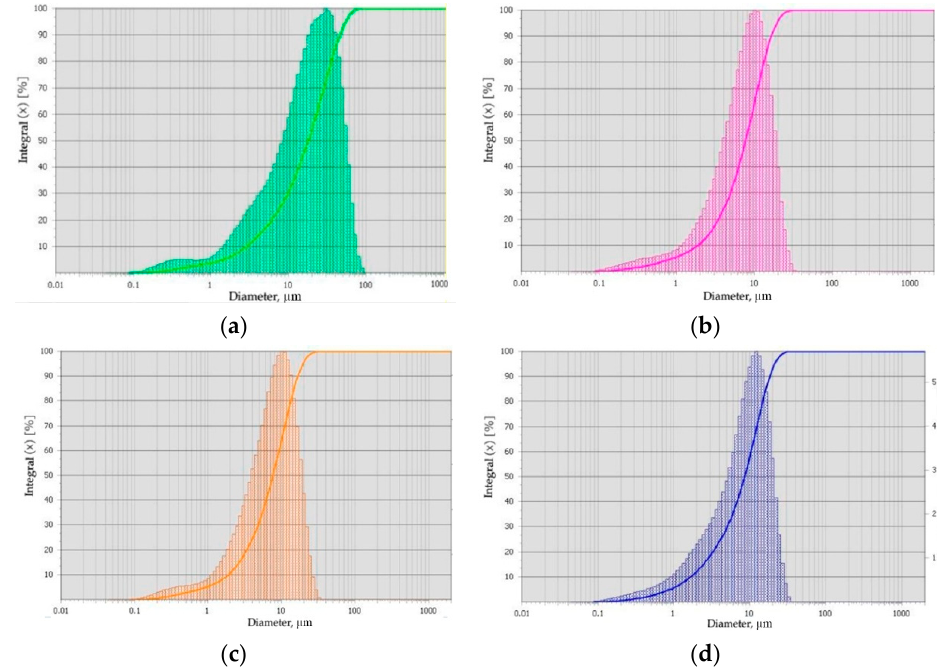
Figure 2. Granulometric composition of binders: ( a ) CEM; ( b ) composite binder (CB)-1; ( c ) CB-2; ( d ) CB-3.